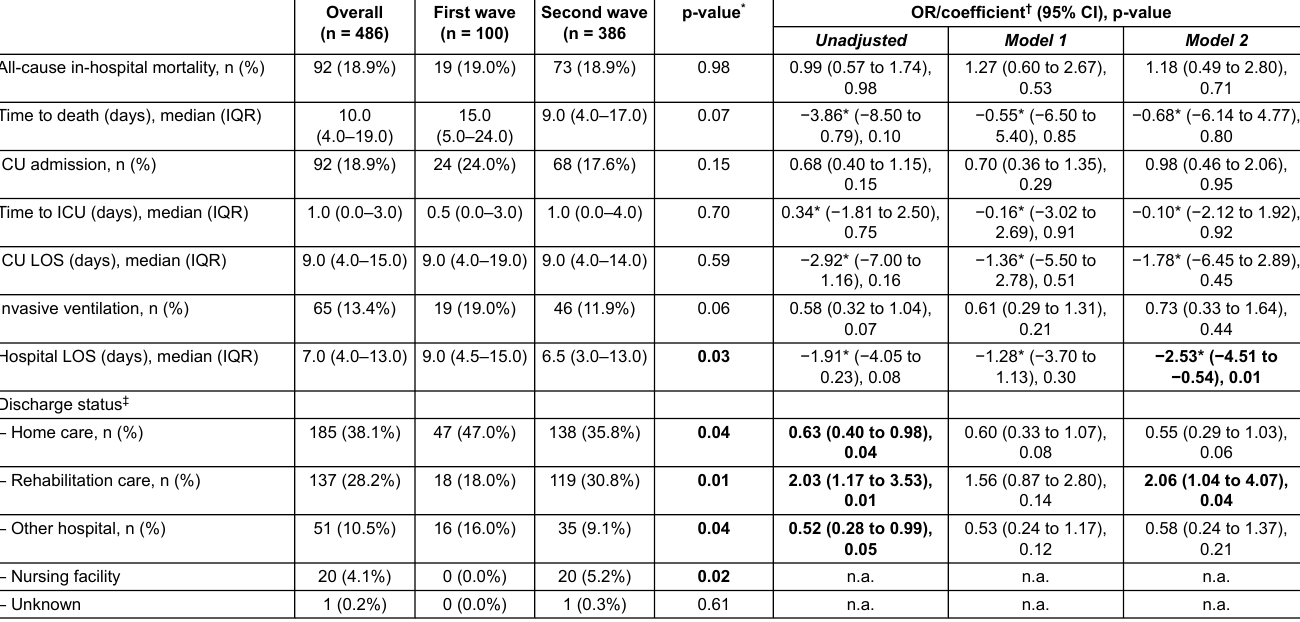
Table S1: Outcomes overall and stratified by wave. Odds ratios and regression coefficients for wave (base = first wave). Overall (n =